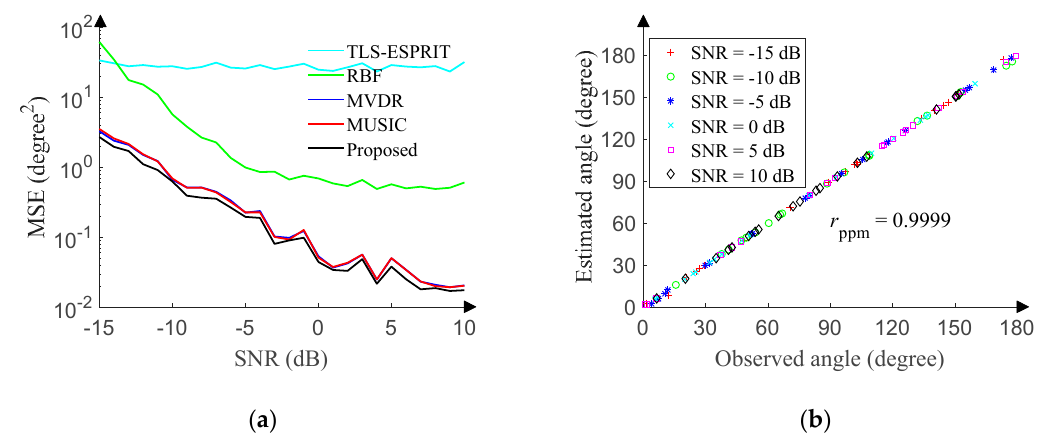
Figure 13. 1D-DOA network performance in Gaussian noise. ( a ) MSE versus SNR. ( b ) Angle correlation diagram.